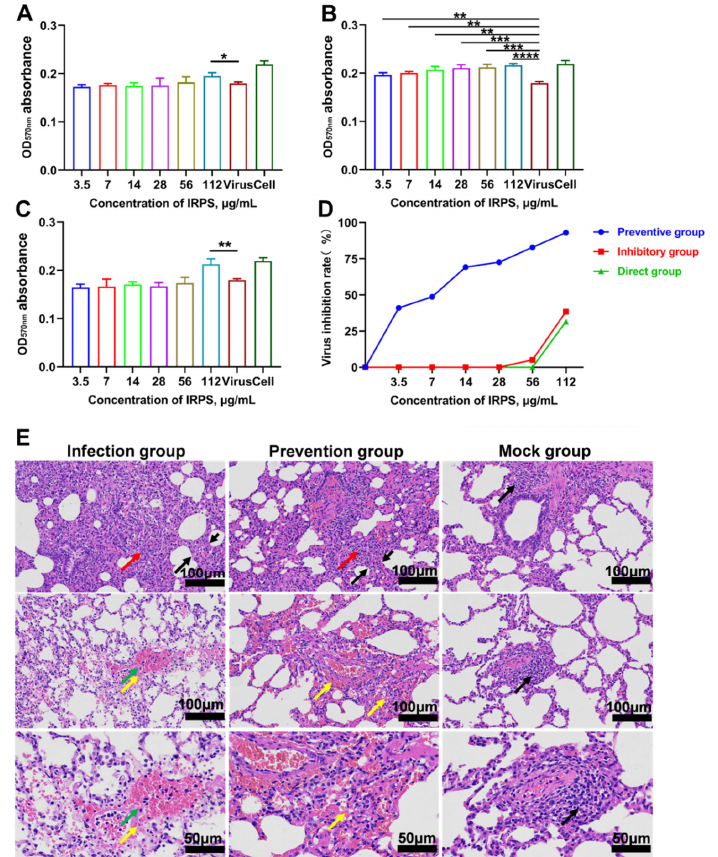
Figure 1. Antiviral study of IRPS in vivo and in vitro. ( A ) Inhibitory effect of IRPS on PRRSV; in the inhibitory assay, at 1.5 h PRRSV infection, cells were treated with different concentrations of IRPS and cell status was observed; ( B ) Preventive effect of IRPS on PRRSV; in the preventive assay, cells were treated with different concentrations of IRPS for 4 h, then 1.5 h PRRSV infection to observe cell status; ( C ) The direct effect of IRPS on PRRSV; in the direct assay, PRRSV was mixed with various concentrations of IRPS and incubated for 1.5 h to observe cell status; ( D ) Percentage inhibition of IRPS on PRRSV; Virus: the concentration of IRPS was 0 µ g/mL. Cell: the normal growing cell. * ( p < 0.05), ** ( p < 0.01), *** ( p < 0.001), **** ( p < 0.0001). ( E ) Effect of IRPS on lung histopathology of PRRSV-infected piglets. Histological observation of representative lungs from three groups (H&E stain, 100 × and 50 × magnification). Infection group: severe thickening of alveolar walls in local tissue(black arrow); alveolar cells can be observed in a small inflammatory cell infiltration (red arrow). local vascular smooth muscle cell necrosis, nuclear dissolution disappears, and eosinophilic homogeneous (yellow arrow); surrounding bleeding (green arrow). Prevention group: local alveolar wall thickening of tissue (black arrow); alveolar wall can be seen in a small inflammatory cell infiltration (red arrow); local hemorrhage, alveolar cavity, and blood vessels can be seen with more red blood cells (yellow arrow). Normal control group: lung tissue of blank group. Tissue alveolar; the bronchial structure is clear; thin alveolar wall; and small inflammatory cell infiltration (black arrow) around bronchial and blood vessels (black arrow); the branch structure is complete, and the epithelial cell morphology is